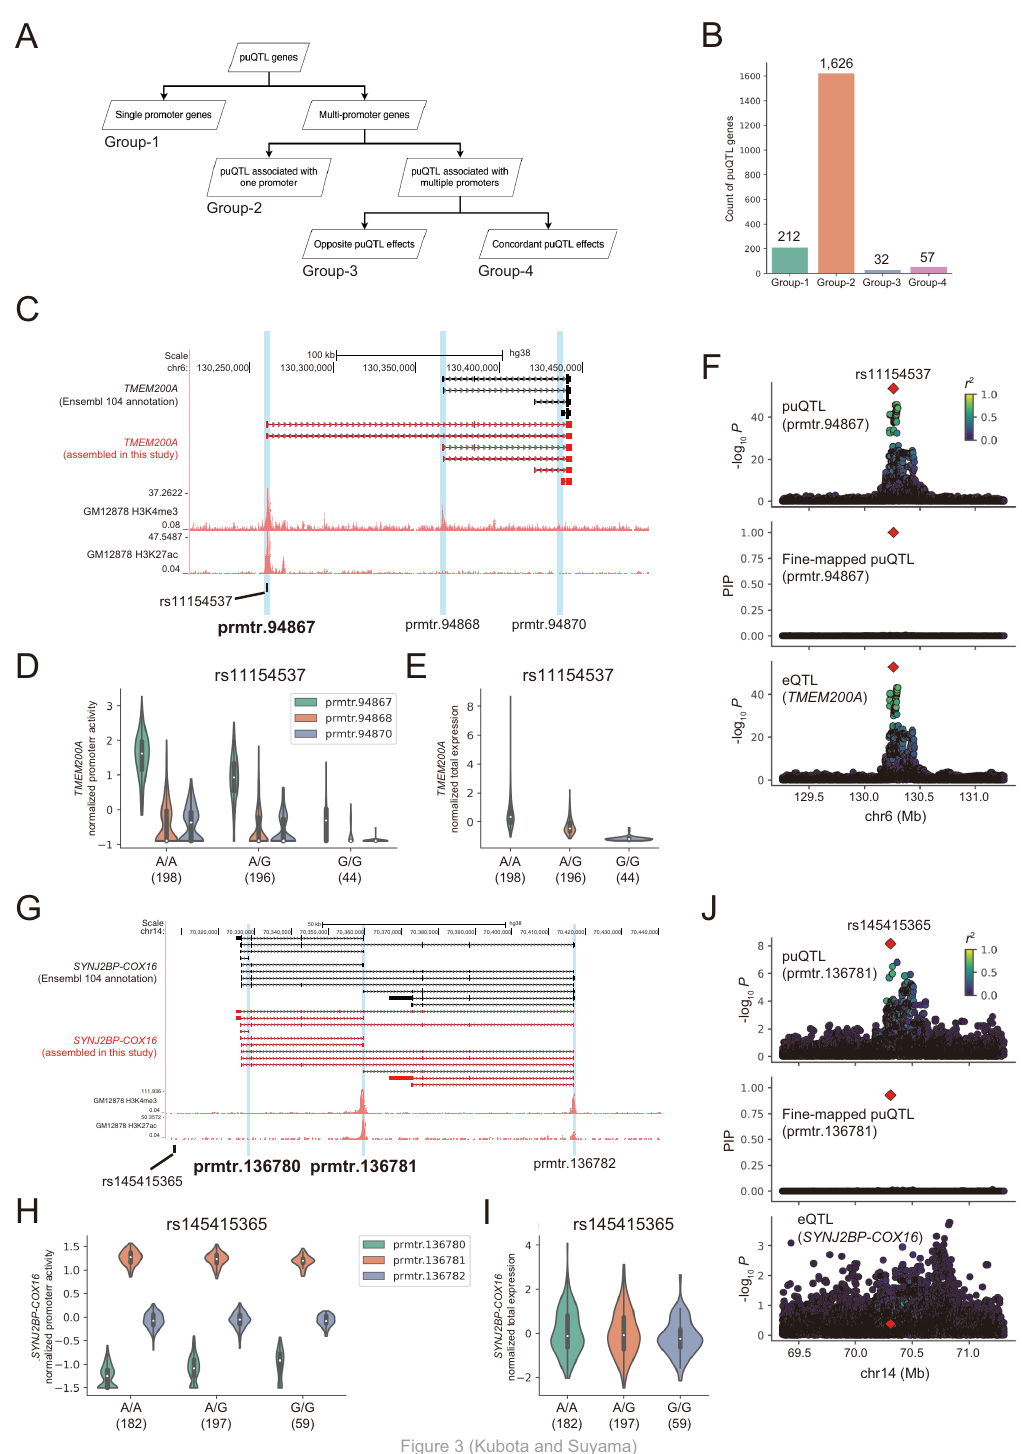
Figure 3 (Kubota and Suyama) Fig 3. puQTL-associated gene classification. (A) The procedure used for puQTL gene classification. (B) Count of each group of puQTL genes. (C) The TMEM200A gene locus. The structures of the TMEM200A gene in the Ensembl 104 annotation and assembled in this study are presented in black and red, respectively, with ENCODE GM12878 H3K4me3 and H3K27ac ChIP- seq signals. The vertical blue bars indicate the location of active promoters. The black bar indicates the location of the rs11154537 variant. (D, E) Comparison of the promoter activities (D) and total expression levels (E) of the TMEM200A